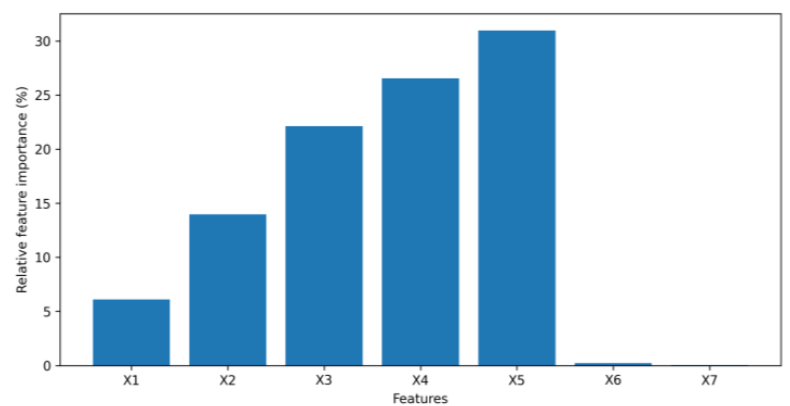
Figure 7. Relative feature importance for simulated data.